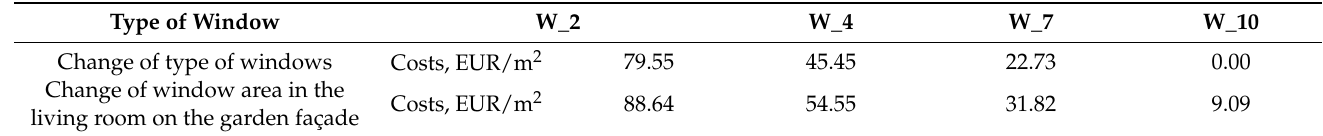
Table 13. Additional costs—windows.